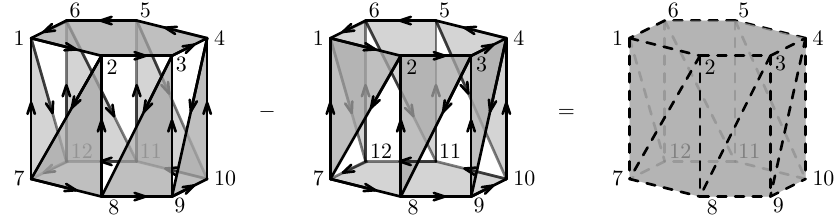
Figure 6 . Sphere move between (3.19) and (3.20) for n =12. The corresponding sets of triples are T 1 = f (1 ; 2 ; 3 ; 4 ; 5 ; 6) ; (7 ; 8 ; 2) ; (8 ; 9 ; 3) ; (9 ; 10 ; 4) ; (10 ; 11 ; 5) ; (11 ; 12 ; 6) ; (12 ; 7 ; 1) g and T 2 = f (1 ; 2 ; 7) ; (2 ; 3 ; 8) ; (3 ; 4 ; 9) ; (4 ; 5 ; 10) ; (5 ; 6 ; 11) ; (6 ; 1 ; 12) ; (7 ; 8 ; 9 ; 10 ; 11 ; 12) g